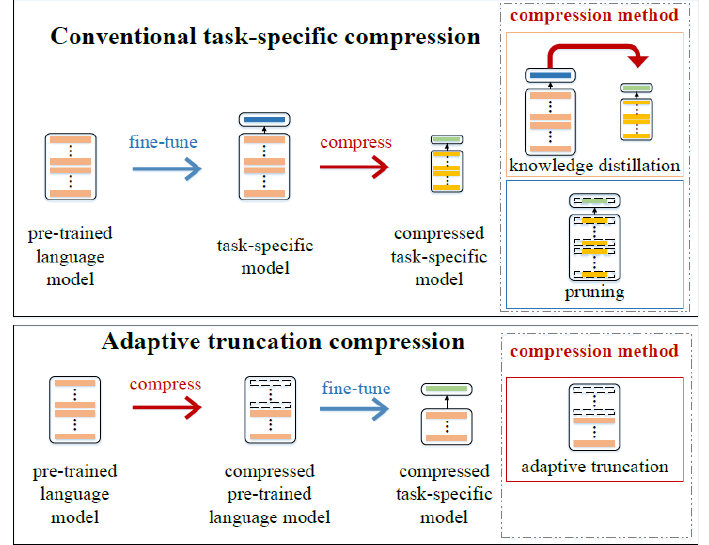
Figure 1. The general procedures of conventional task-specific compression ( upper box) and the adaptive truncation compression proposed in this article ( lower box). Conventional methods commonly conduct compression after fine-tuning, whereas ours conducts compression prior to fine-tuning. Moreover, knowledge distillation requires an additional training process for the teacher to teach the student to make predictions. Pruning methods are needed evaluate the importance of each model unit or learned weight to determine which should be masked and then perform another round of fine-tuning; our method demands no additional training.